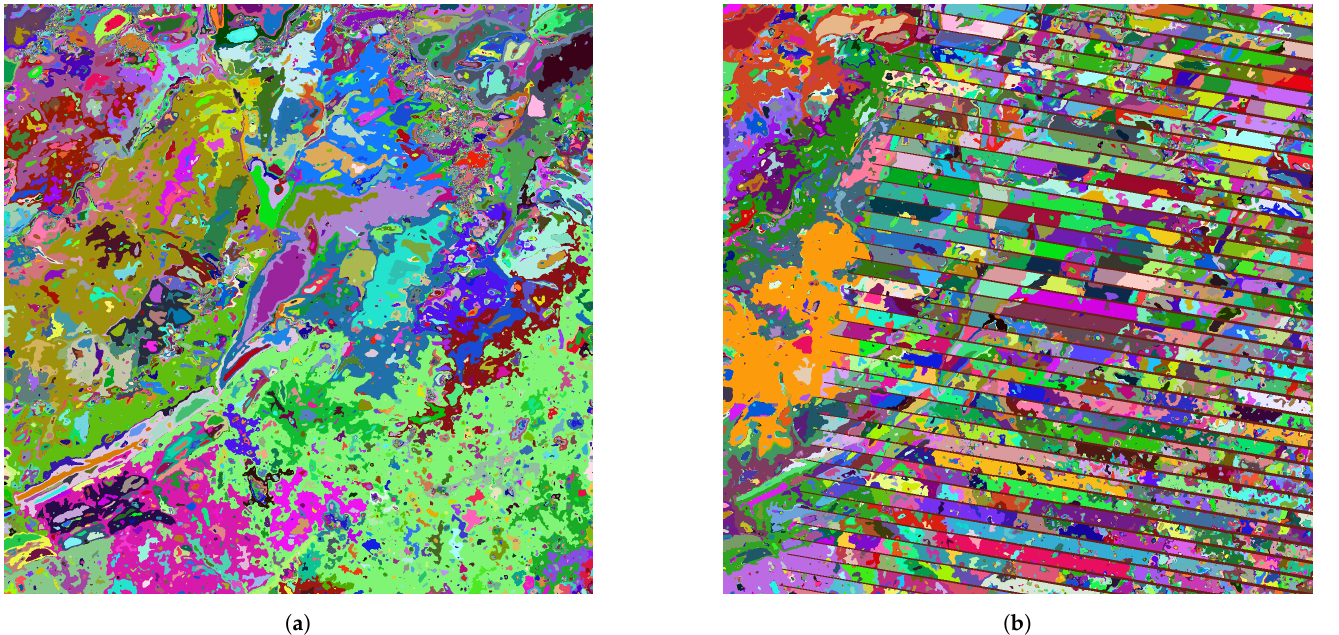
Figure 17. Clump maps for base and target images of Figure 16. ( a ) base clumps; ( b ) target clumps.